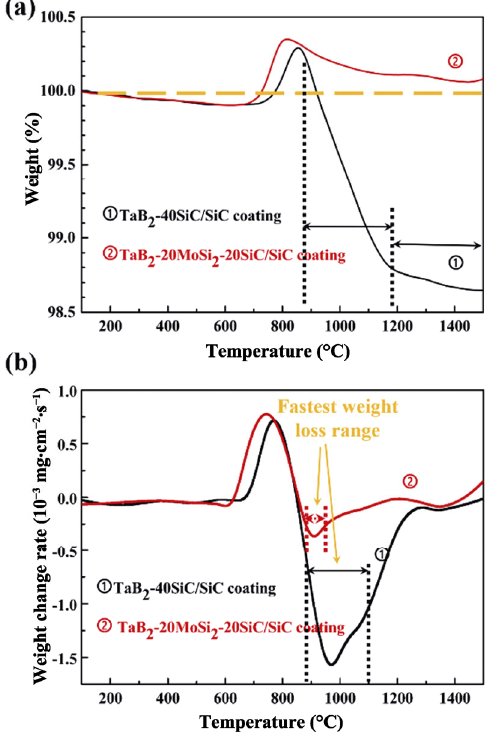
Fig. 7 (a) TGA curves of the samples from room temperature to 1500 ℃ ; (b) weight change rate curves of the samples from 25 to 1500 ℃